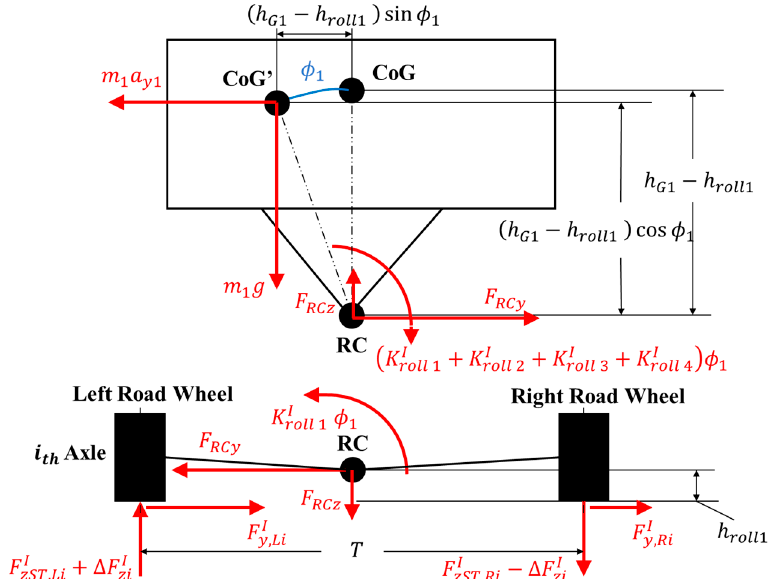
Figure 5. Free body diagram of the ATV (front unit